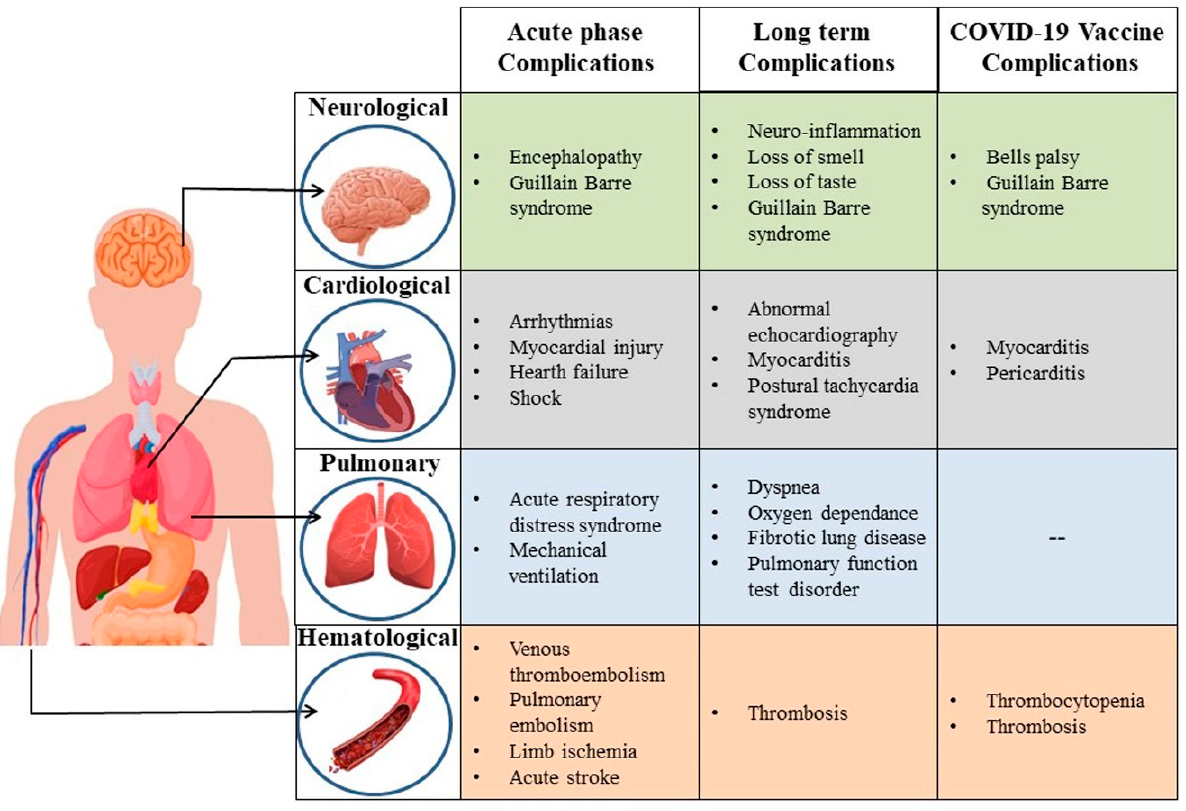
Figure 1. Schematic representation of complications in different organ system during acute and long-term sequelae of COVID-19 as well as adverse events post COVID-19 vaccination.